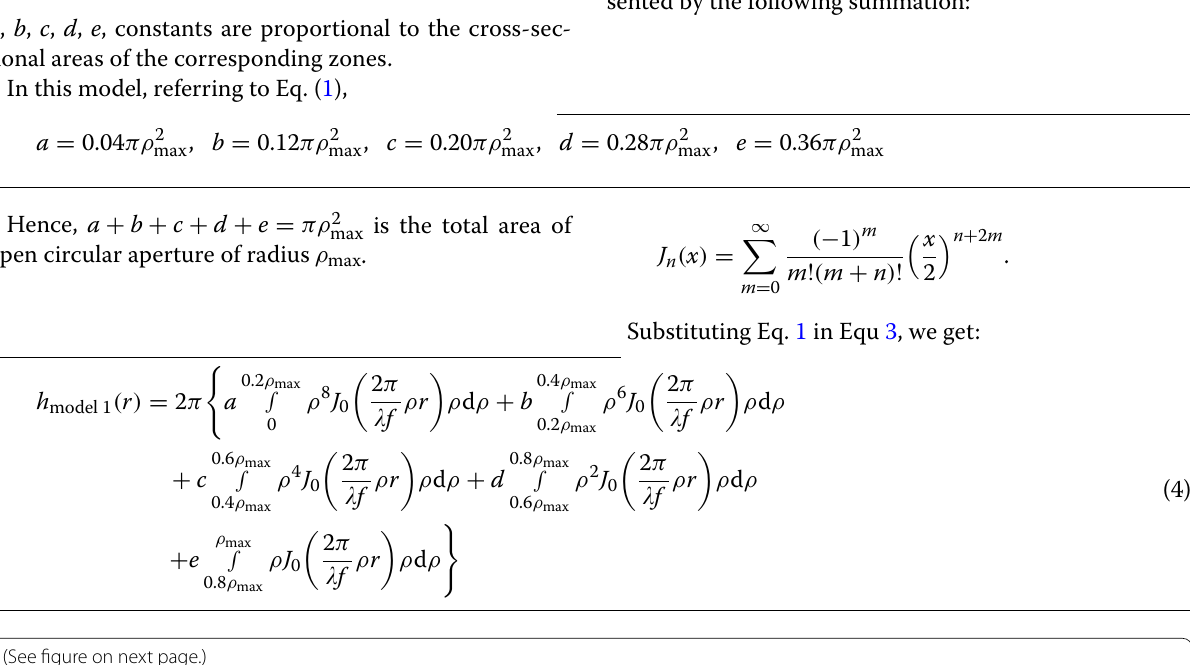
aperture in the form of a polynomial distribution with five equal zones. The concentric zones have distributions ρ 8 , ρ 6 , ρ 4 , ρ 2 and ρ computed from the aperture center. The matrix dimensions have 512 polynomial aperture shown in the ( b ) at the center of the aperture at constant